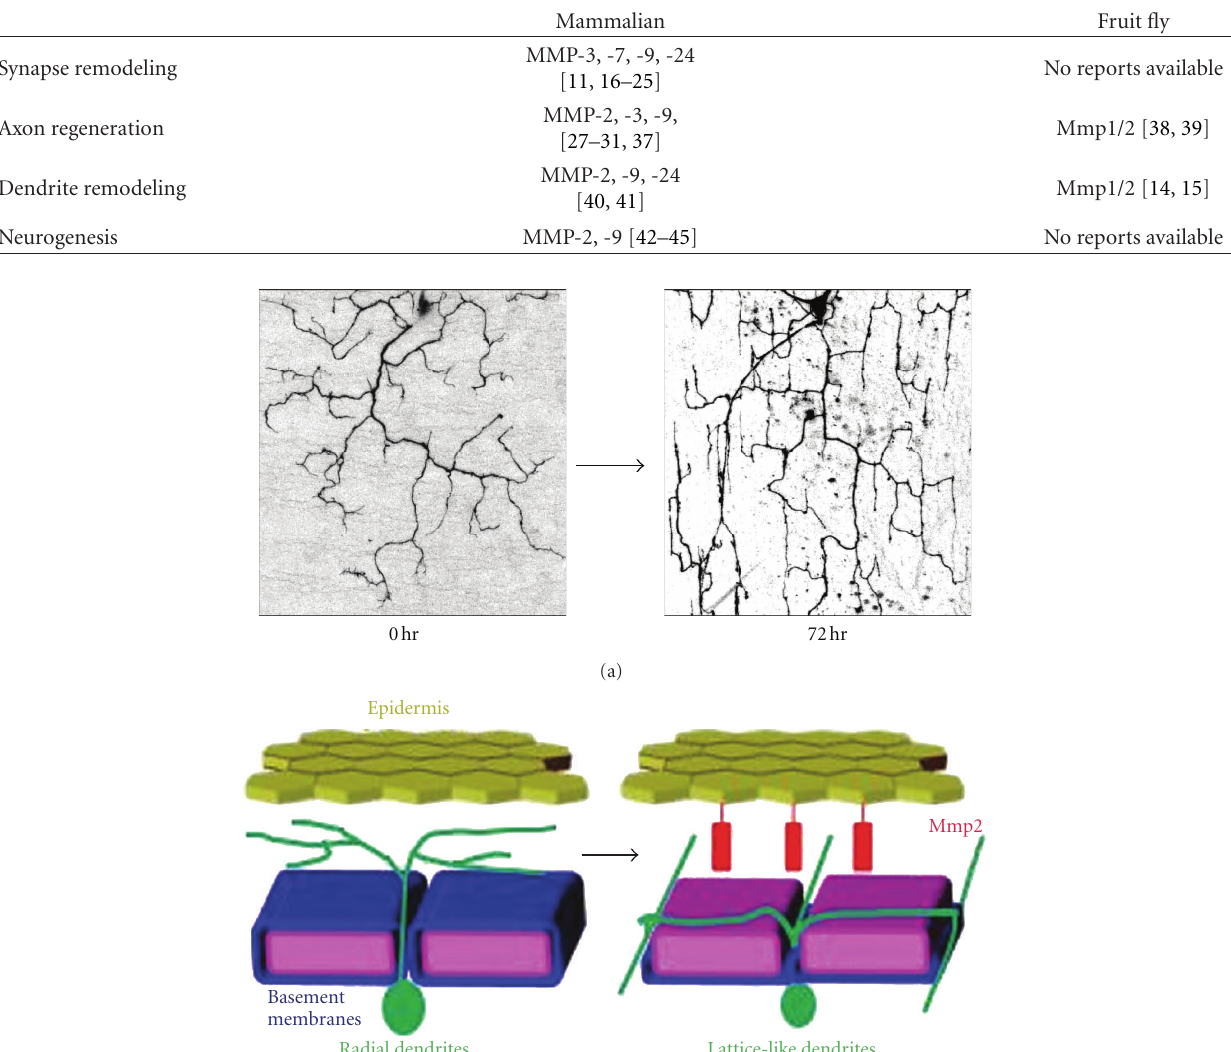
Table 1: MMP family proteins in neural circuit remodeling.